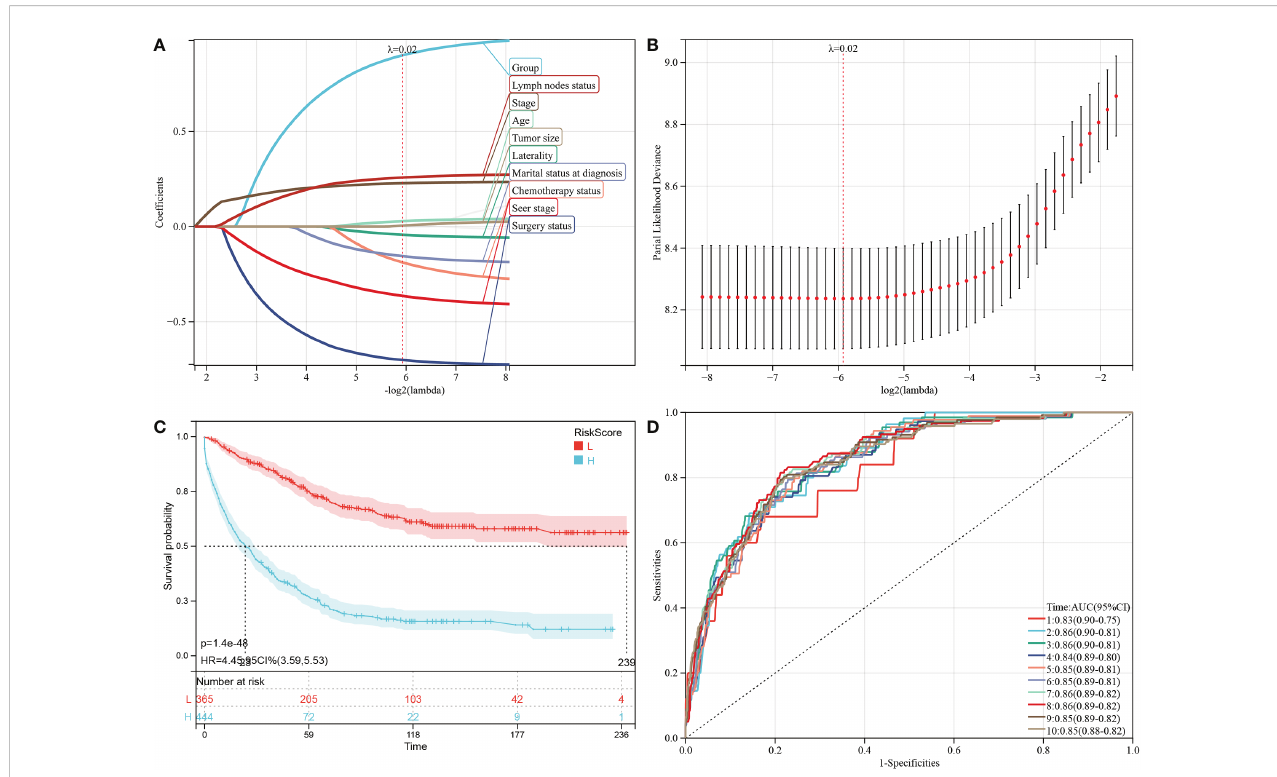
FIGURE 5 Construction and evaluation of CSS associated predictive models. (A, B) are the LASSO coef fi cient pro fi les and LASSO deviance pro fi les, respectively, which show the optimal l value and risk factors. (C) KM survival curves of CSS according to the risk score perform that prognosis of low-risk group is signi fi cantly better than high-risk score group. (D) ROC curves of CSS at 1-10 years according to the risk score in the predictive model data sets.